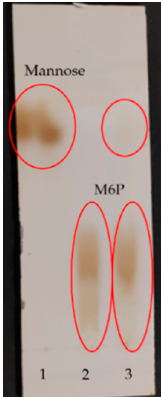
Figure 1. SDS–-PAGE results. The protein of about 30 kDa was the result of enzyme expression in E. coli . Lane1 and lane2, which have overexpression bands (target protein), are both protein electrophoresis bands of recombinant E. coli . Lane M is the marker.